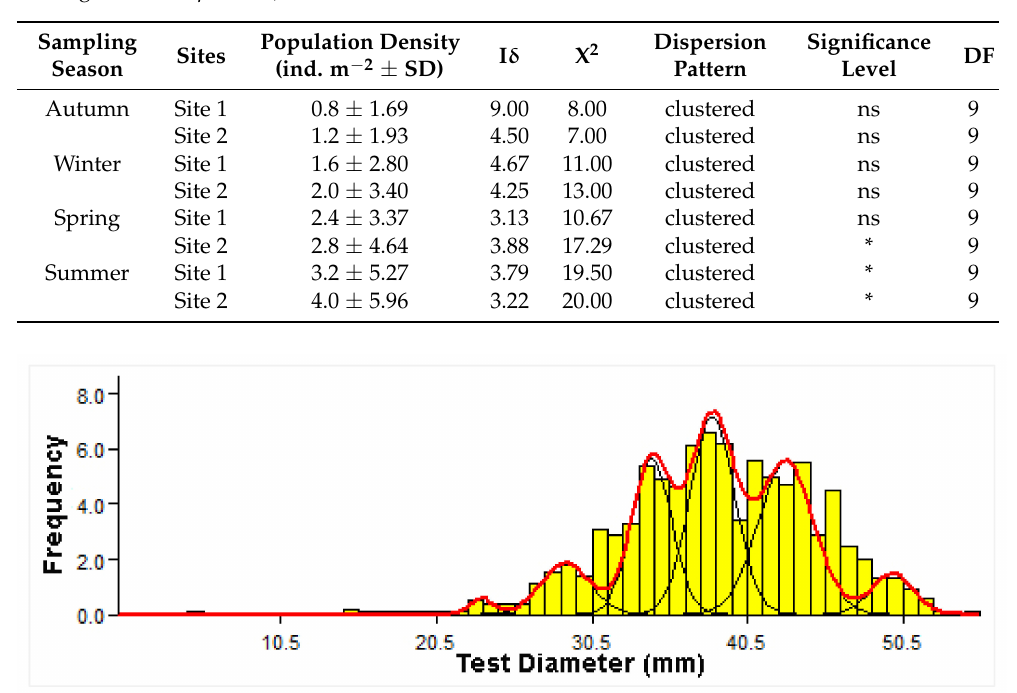
Table 4. Population density (ind. m − 2 ) and dispersion pattern of Arbacia lixula at each sampling site (Site 1 Agios Stefanos, Site 2 Kato Gatzea) and season. SD (standard deviation), I δ (Morisita index of aggregation), DF (degrees of freedom), X 2 (chi-square test values), significance level (ns: non-significant, *: p < 0.05).